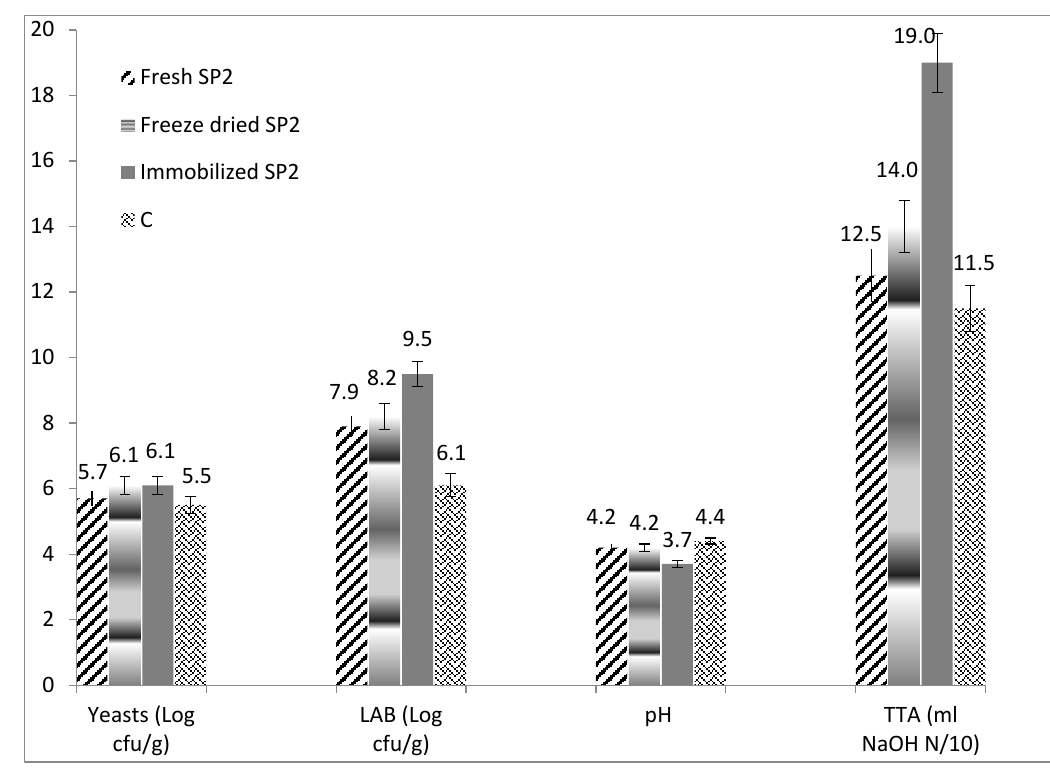
Figure 1. Viable cell counts (log cfu / g) of yeasts and lactic acid bacteria (LAB), total titratable acidity (TTA), and pH values of the sourdoughs prepared with frsh P. pentosaceus SP2 cells (Fresh SP2), with freeze-dried P. pentosaceus SP2 cells (Freeze-dried SP2), with immobilized freeze-dried P. pentosaceus SP2 cells (Immobilized SP2), and commercial sourdough with wild microbiota (C), after incubation at 30 °C for 24 h.